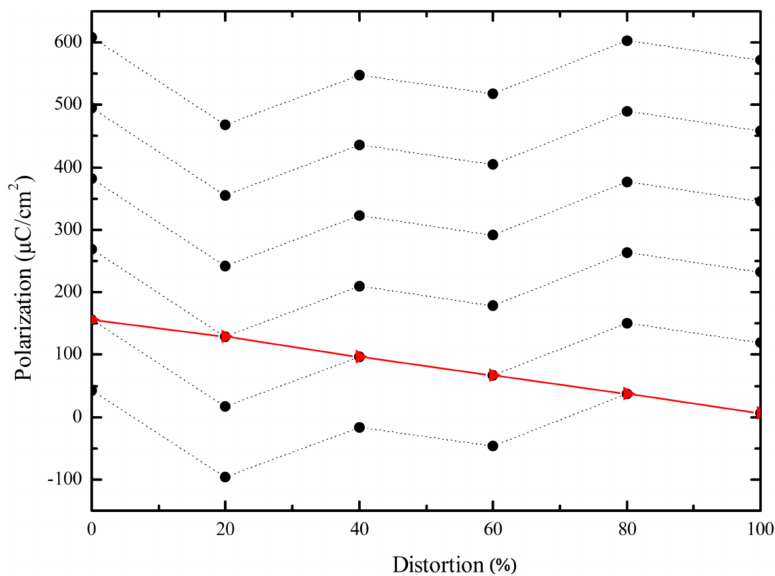
Figure 3. Calculated polarization as a function of percentage of distortion from the centrosymmetric structure (0% distortion) to + P 4 mm structure for BFO. The black dots are the calculated polarization at small steps of λ for the different crystals considering the polarization quantum jump, and the red line is the real evolution of polarization with